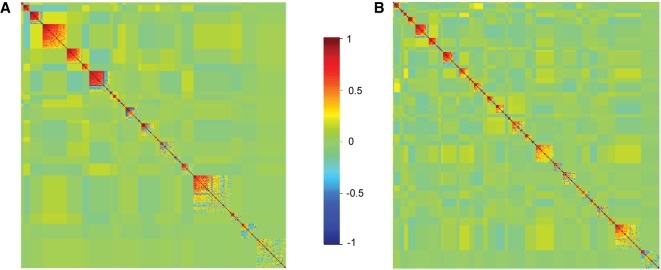
Modulated modularity clustering of metabolites across the 40 DGRP lines in females (A) and males (B). Modules are ordered from the top left corner to the bottom right corner based on the average absolute correlation of each module.